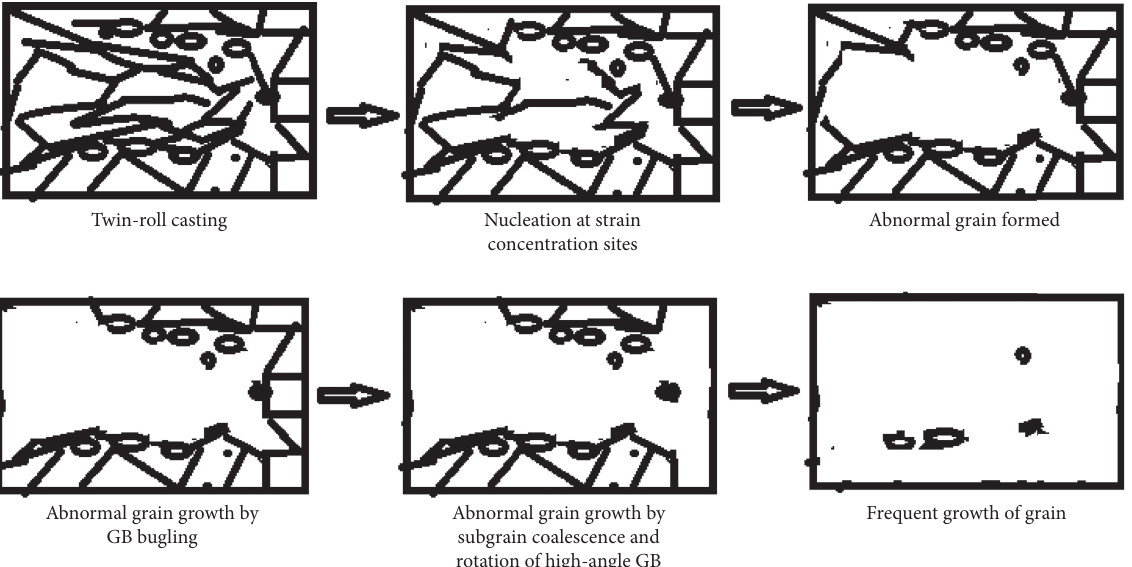
Figure 13: The mechanism for grain growth assisted by particle